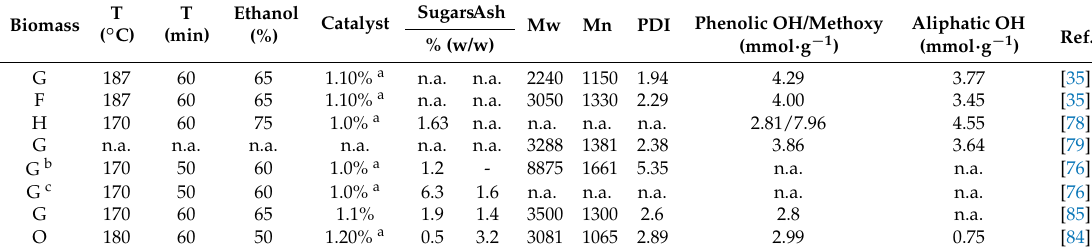
Table 3. Properties of organosolv softwood